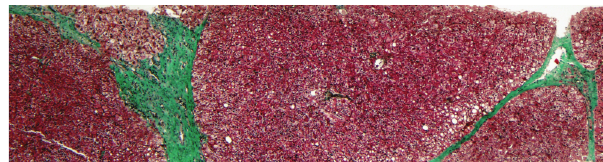
Figure 1: Liver biopsy. Architectural distortion with nodular areas bounded by fibrous tract